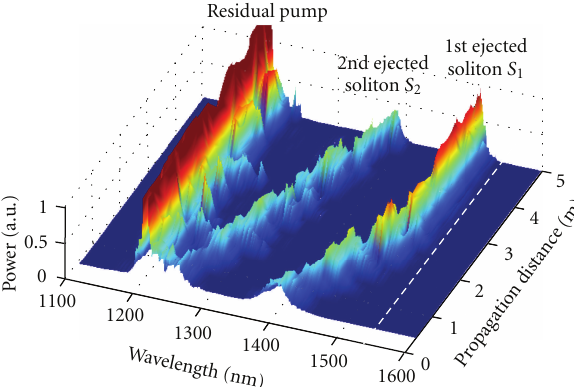
Figure 4: Evolution of the experimental output spectrum (linear scale) with fiber length (from 0.4 to 5m) for 270 fs pump pulses at 1200 nm. The white dashed line represents the PBG edge.